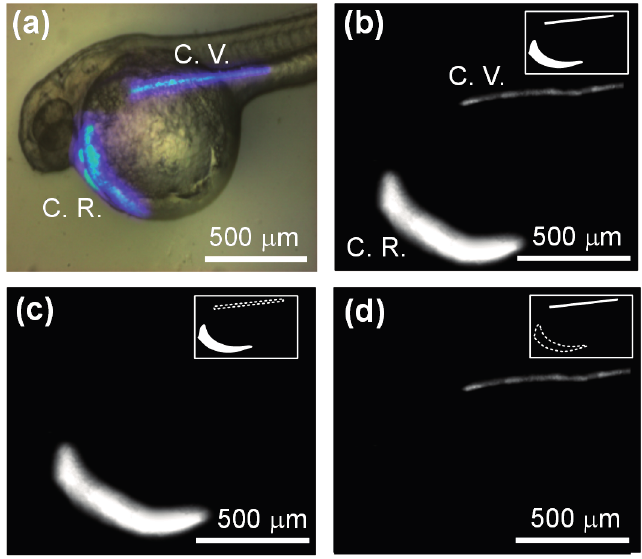
Figure 7. ( a ) The optical image of a 48 hpf zebrafish at a normoxic condition (20% pO 2